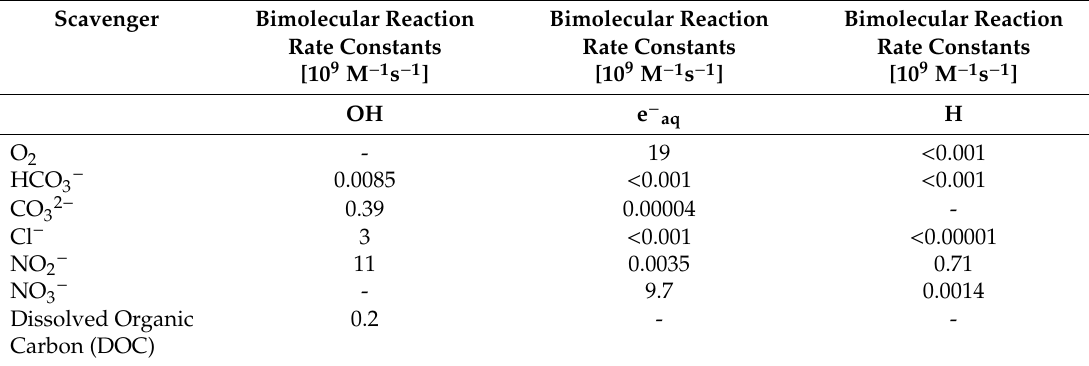
Table 5. Scavenger molecules’ removal rates by di ff erent radicals (data from